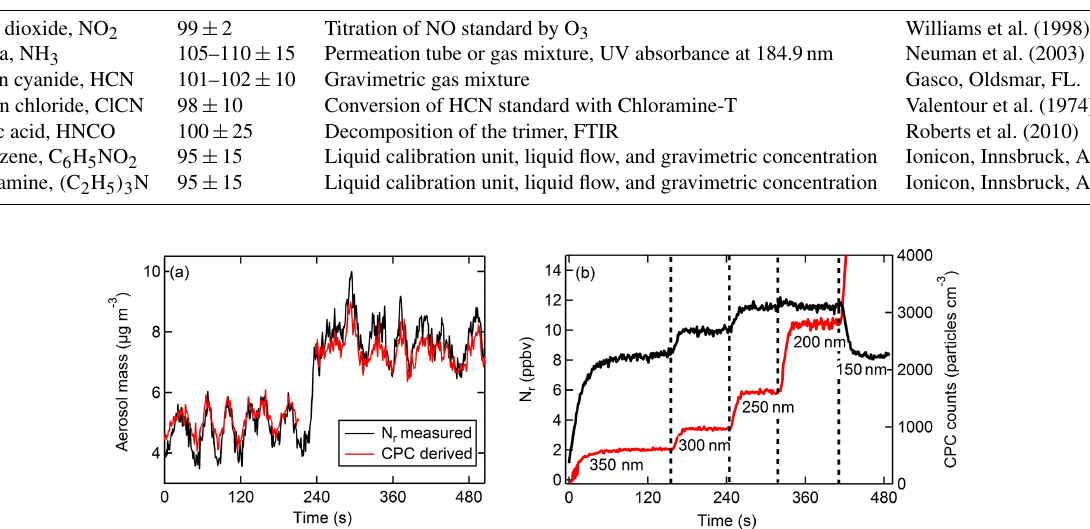
Figure 3. The signal resulting from particles only. (a) Real-time N r -measured (black) and CPC-derived (red) aerosol mass concentrations (µgm − 3 ) from an atomized solution of NaNO 3 . (b) Time response of the N r signal (ppbv) shown in black (left axis), and the CPC signal (particlescm − 3 ) shown in red (right axis), as particle sizes of ( NH 4 ) 2 SO 4 are selectively changed. The dashed vertical lines and labels indicate the singly charged particle diameter selected with the